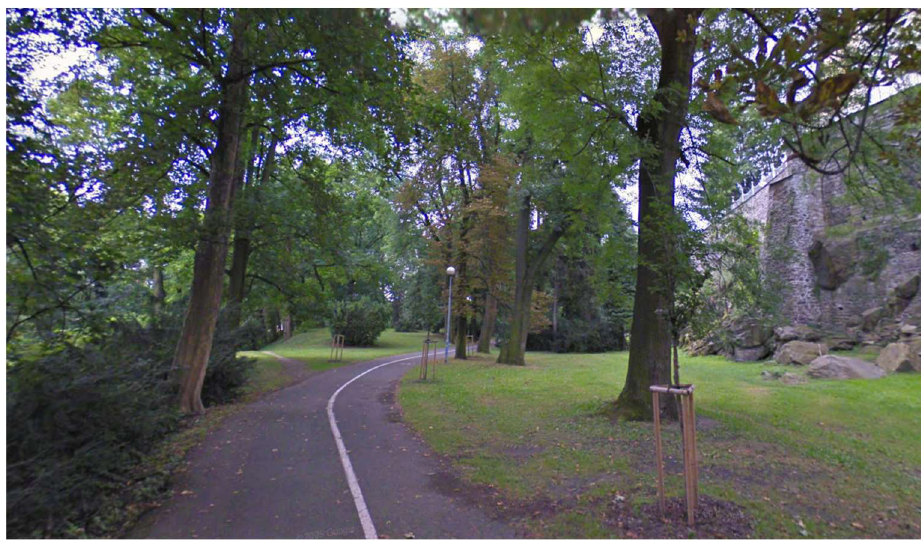
Figure 7. The park environment.